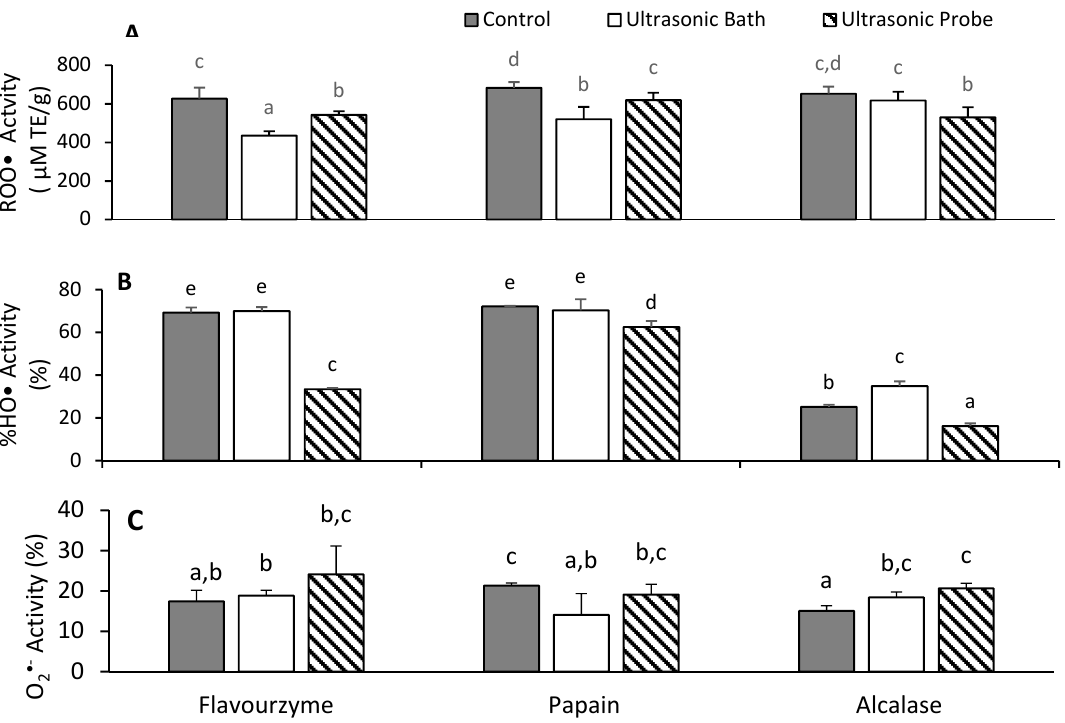
Figure 3. ( A ) Peroxyl radical ( A ), Hydroxyl radical ( B ), and Superoxide radical ( C ) scavenging activities of hydrolysates. Data are expressed as the mean of triplicates ± the standard deviation. The letters above each bar represent significant di ff erences as determined with a least significant di ff erence (LSD) test in a one-way ANOVA ( p -value < 0.05).